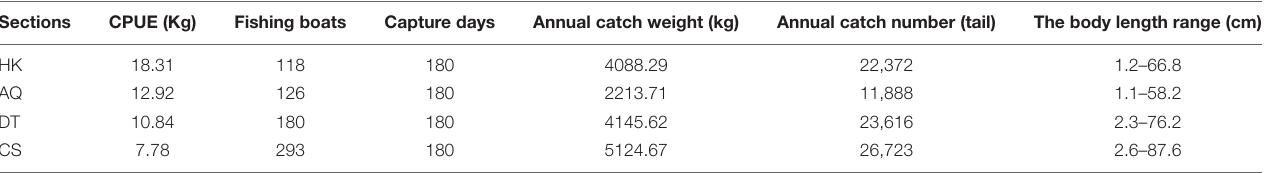
TABLE 1 | Catch statistics of the sliver carp in each